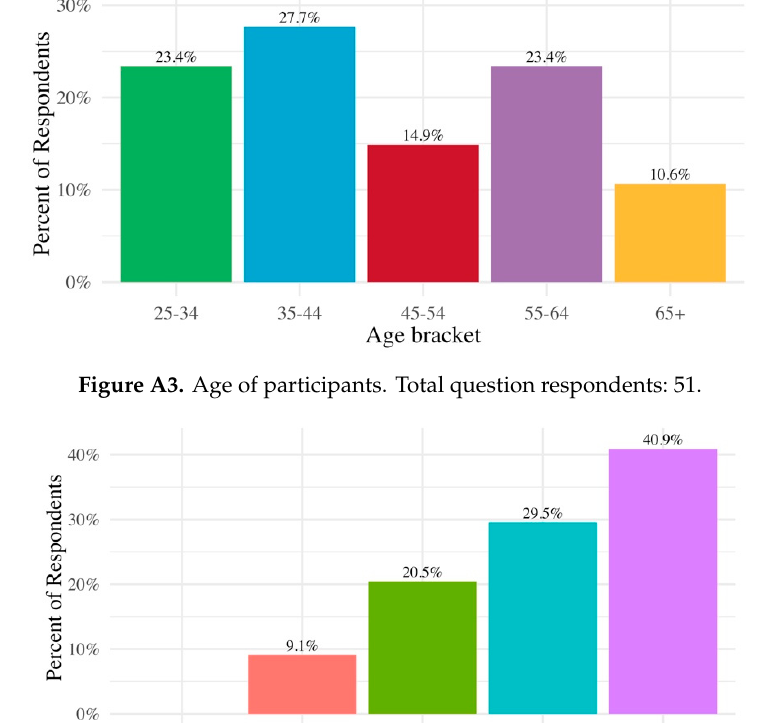
Figure A5. Knowledge of participants regarding potential soil remediation methods. Total question respondents: 41.